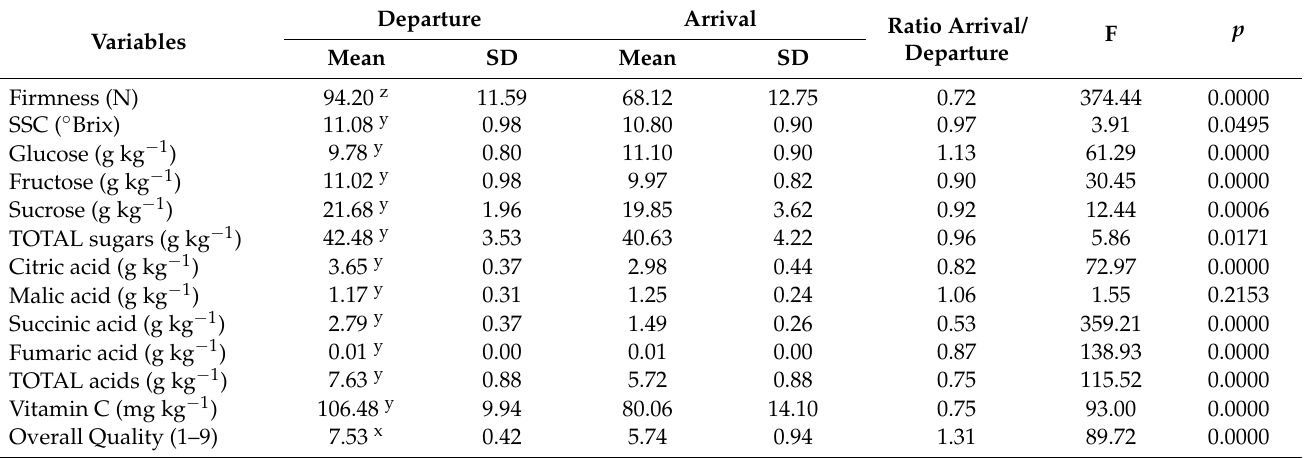
Table 4. Main changes in quality parameters of melons during the transport itinerary (Janda í ra, Brazil to Castell ó n, Spain). F-values and p -values are the results of the one-way ANOVA for the factor “transport: arrival vs. departure”, red colour indicates significant